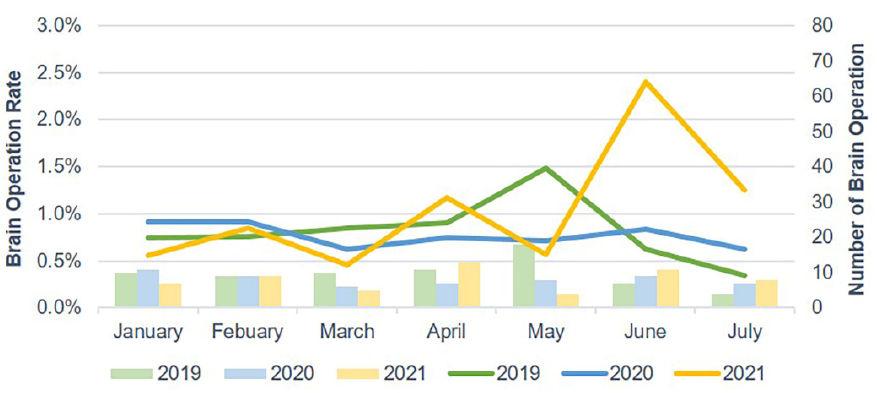
Figure 7. Brain operation rate for TBI in the ED from January to July 2019, 2020, and 2021. ED, emergency department; TBI, traumatic brain injury.